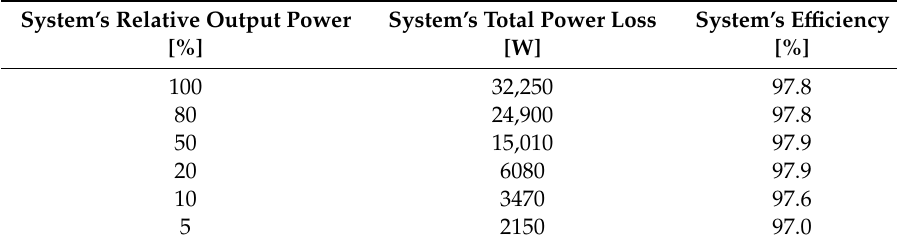
Table 3. Power loss and system’s efficiency in the MNS.